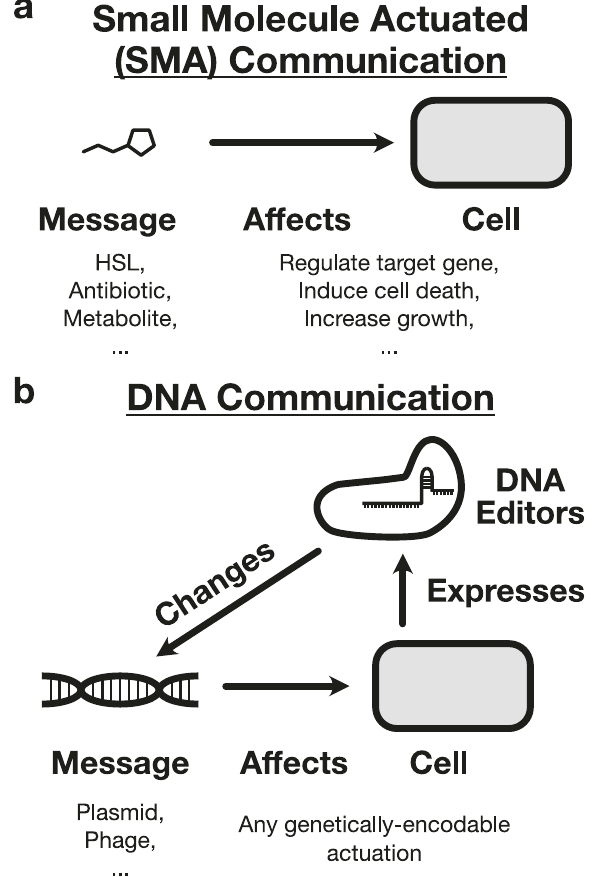
Fig. 1 | Architectures for engineered intercellular communication. a Small molecule actuated (SMA) communication systems exhibit message-channel cou- pling, meaning thatthe behavior they induceinthe receiver cellishard-coded into the molecular identity of the signaling molecule itself. This molecular identity cannot be changedwithout disrupting the functioning ofthe channel itself. b DNA communication systems exhibit message-channel decoupling, meaning that a given channel can transmit multiple types of messages to induce any genetically- encodable response in the receiver cell. Furthermore, the cells themselves can express molecular DNA editors to change the content of the messages in situ, closing the loop to enable autonomous system recon fi